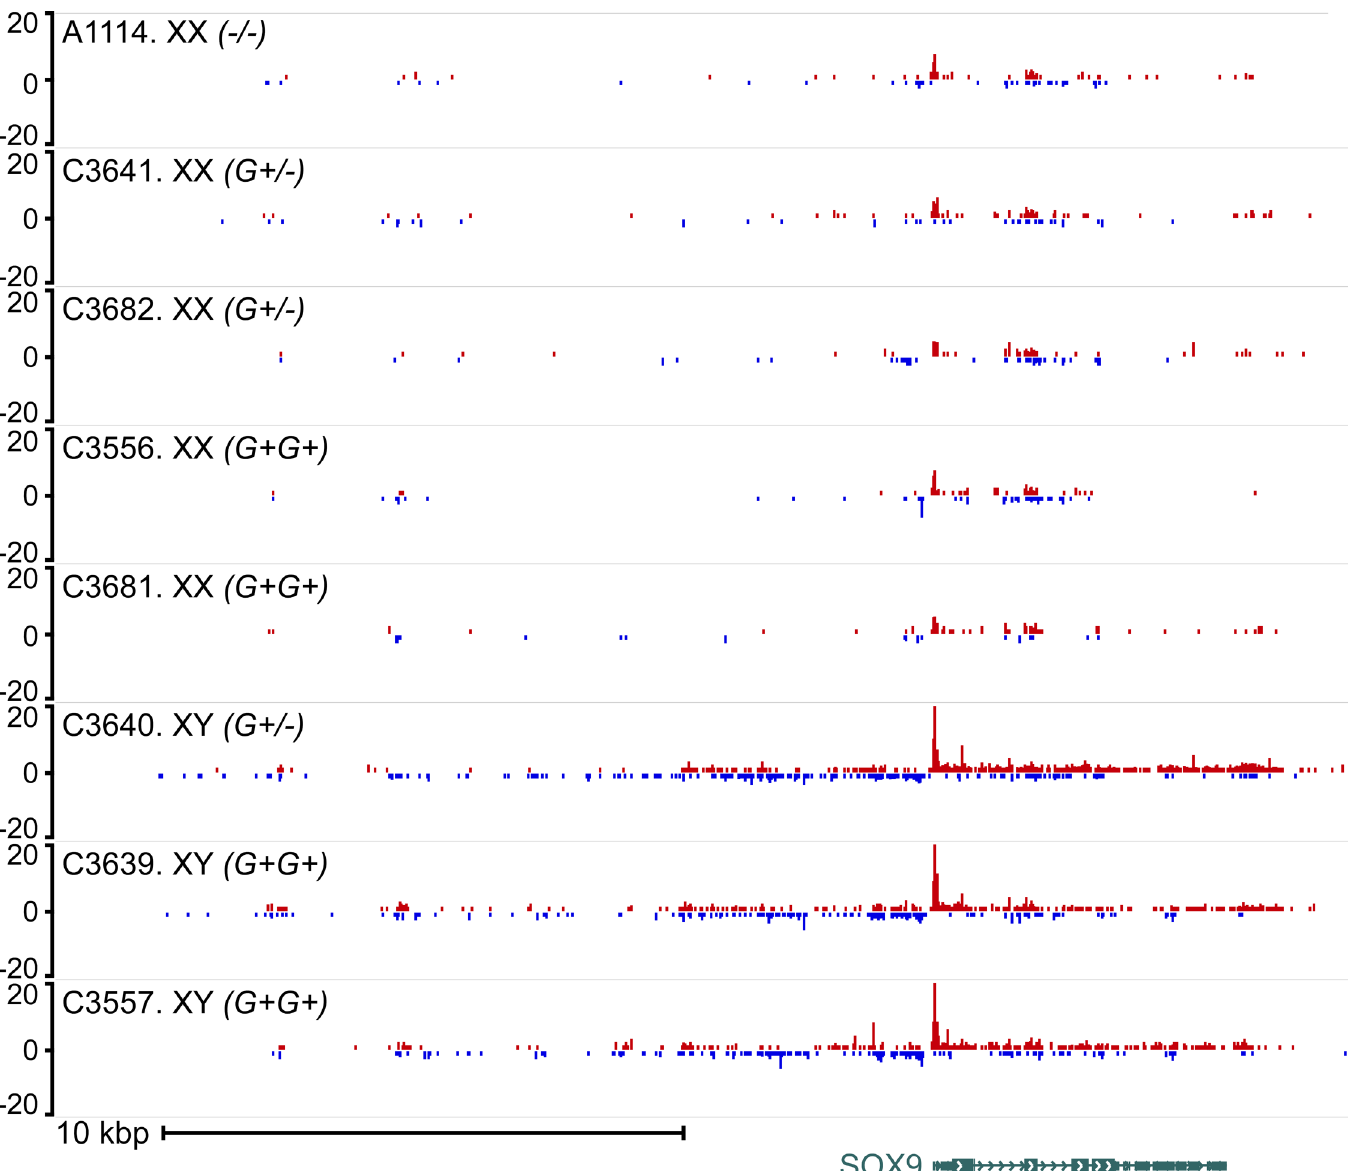
Fig 6. Genome browser view of the raw PRO-seq signal near the SOX9 gene in d39 gonads. SOX9 expressionwas not significantly elevated in d39 XX DSD gonadsat risk comparedto those of XX age-matched controls. The SOX9 signal is highestin XY littermate control gonads (C3640,C3639, C3557) and much lower in the age-matched XX control (A1114) and XX DSD gonadsat risk (C3641, C3682, C3556, C3681).For each sample, histograms show reads alignedto the plus strand (top, red) and minus strand (bottom, blue). Listed at left are embryo ID number, group (XX/XY) and genotypeat the insertionlocus: wild type ( -/- ), homozygous( G+G+ ), and heterozygous ( G+/- ) for the guanineinsertionassociated with XX DSD. RefSeq gene annotation is shown belowthe plot (CanFam3.1).